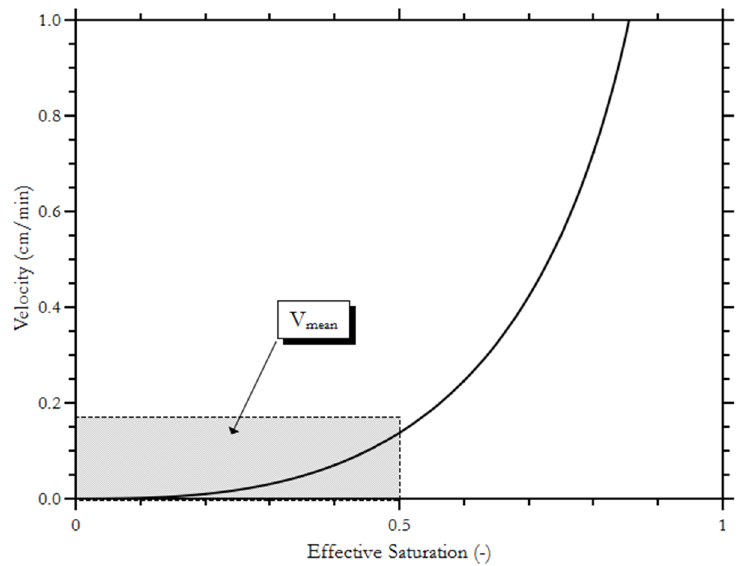
Figure 5. Computation of the velocity value for the determination of the mesh size as indicated in Equation